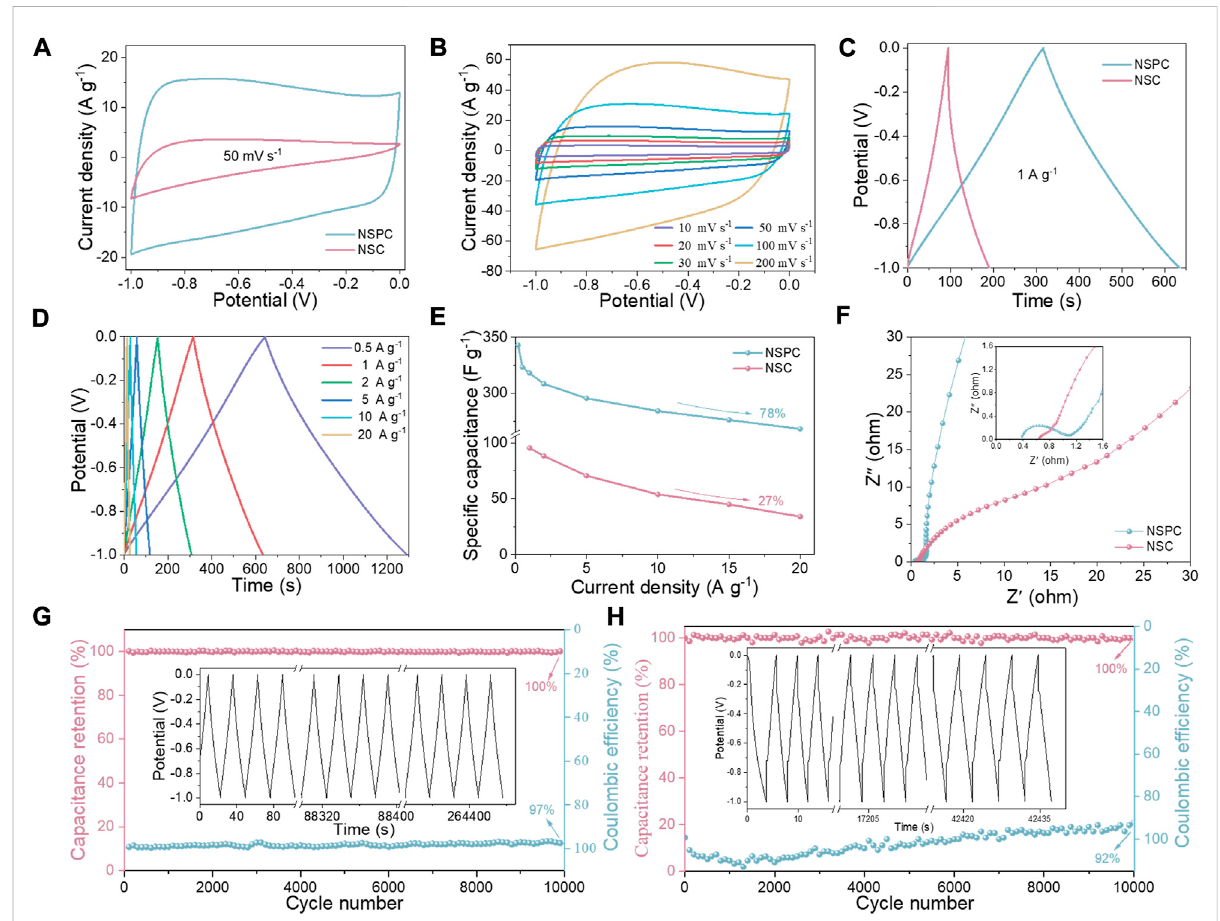
FIGURE 4 ComparativeelectrochemicalperformanceofNSCandNSPCin6 MKOHelectrolyte: (A) CVcurvesat50 mV s − 1 , (B) CVcurvesofNSPCatscan rates ranging from 10 to 200 mV s − 1 , (C) GCD pro fi le at 1 A g − 1 , (D) GCD curves of NSPC at the current density ranging of 0.5 – 20 A g − 1 , (E) Speci fi c capacitancesatdifferentcurrentdensities, (F) Nyquistplots,and (G – H) cyclingstability andCoulombic ef fi ciencyofNSPCandNSCat20 A g − 1 (inset are GCD curves after 10,000